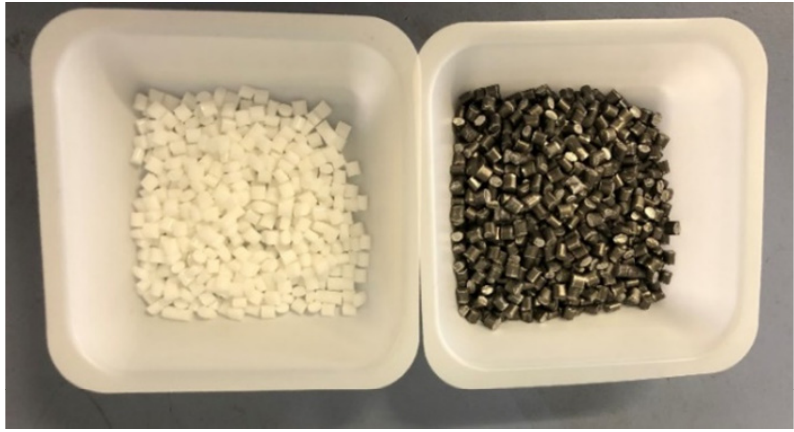
Figure 1. The Arboblend V2 Nature pellets: ( left ) virgin and, ( right ) silver-coated pellets. According to the manufacturer [13], the thermoplastic material Arboblend ® is based on different biopolymers such as lignin, polyester, polylactic acid, starch, bio-polyolefins, natural resins, cellulose and organic additives, but also natural reinforcing fibers. Depend- ing on the Arboblend ® type, its structure varies (up to 100% renewable raw materials) and also responds to various consumer requirements.